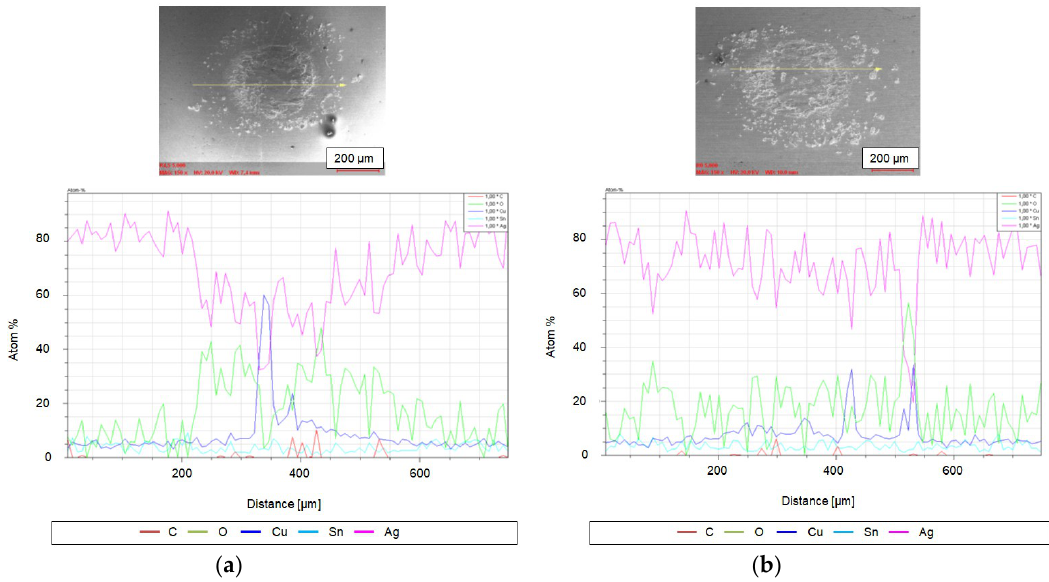
Figure 7. SEM images of the wear scars and EDS in X-ray Linescans mode across the contact area after 5000 fretting cycles: ( a ) on the sphere; ( b ) on the plane.